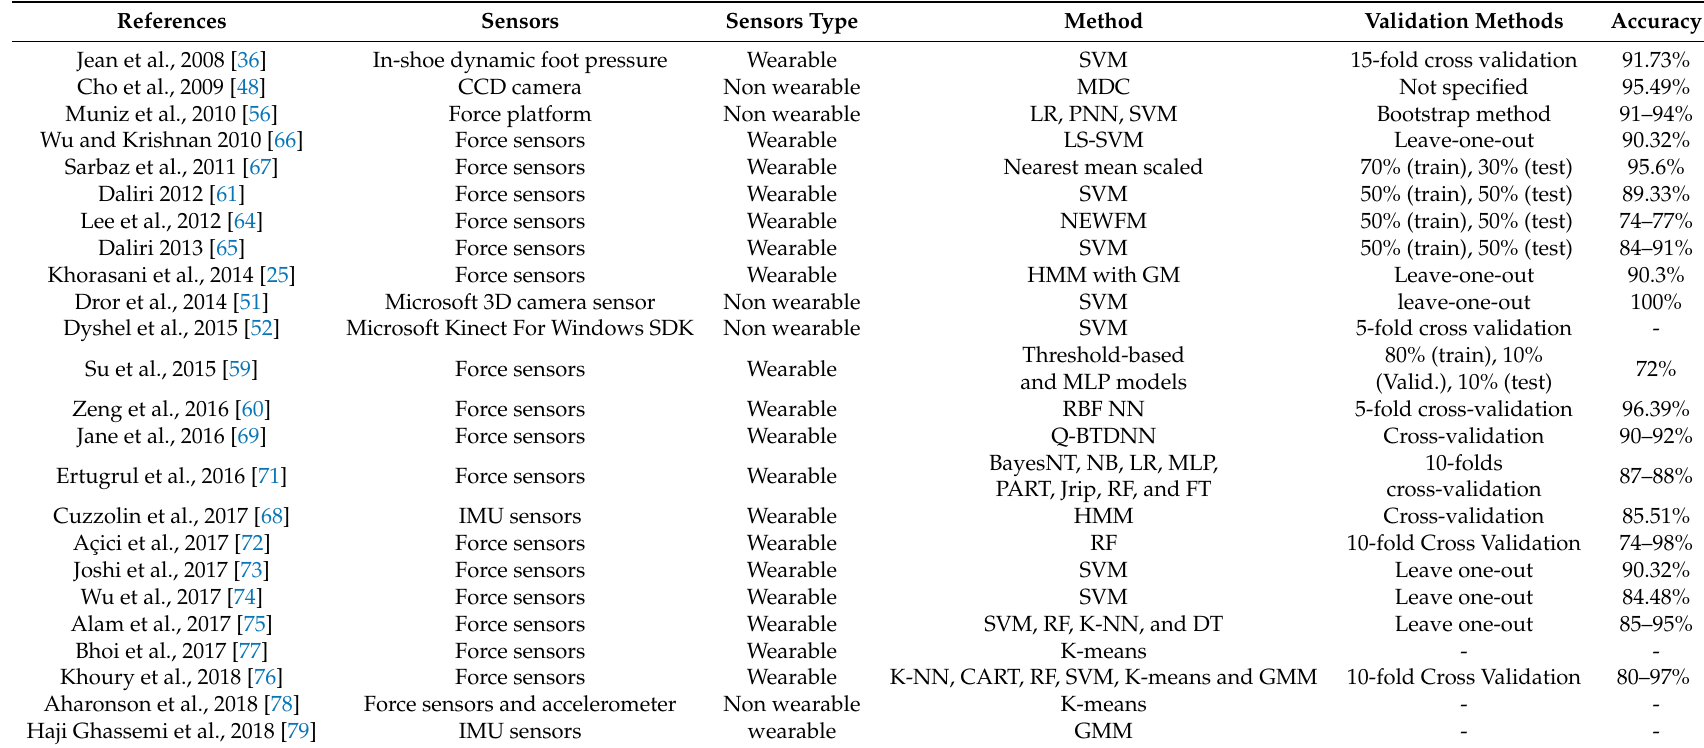
Table 1. Synthetic review of studies on PD